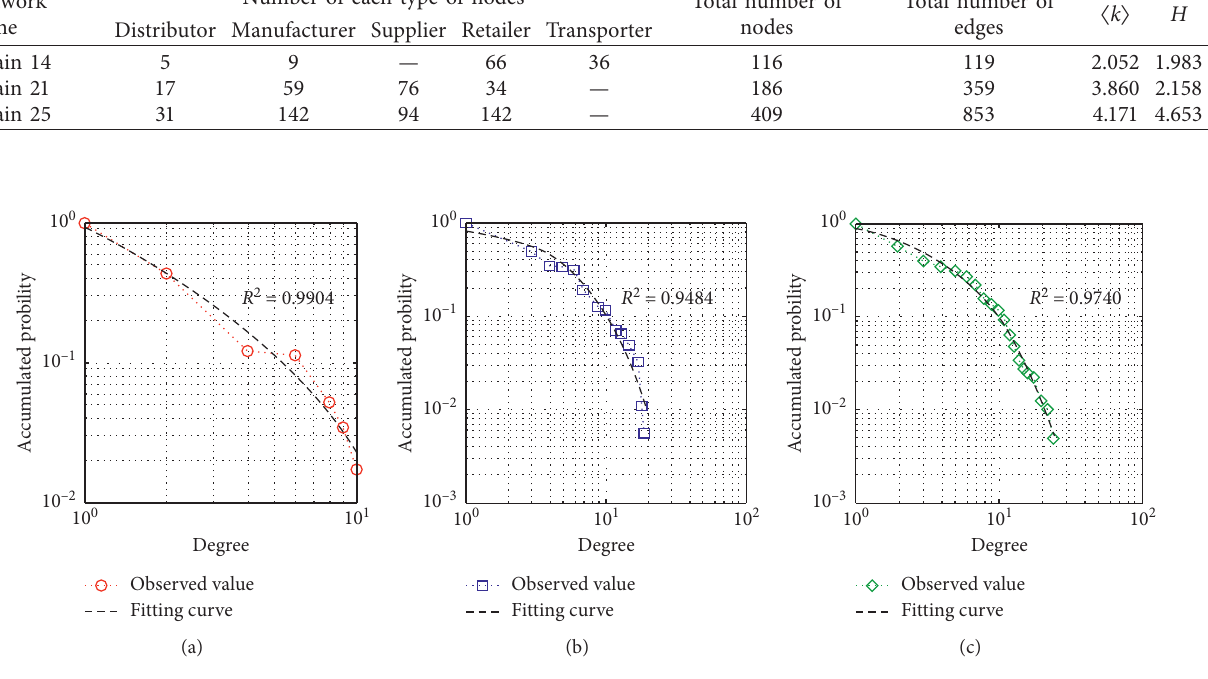
Figure 5: Degree distributions of real-life supply networks. (a) Chain 14. (b) Chain 21. (c) Chain